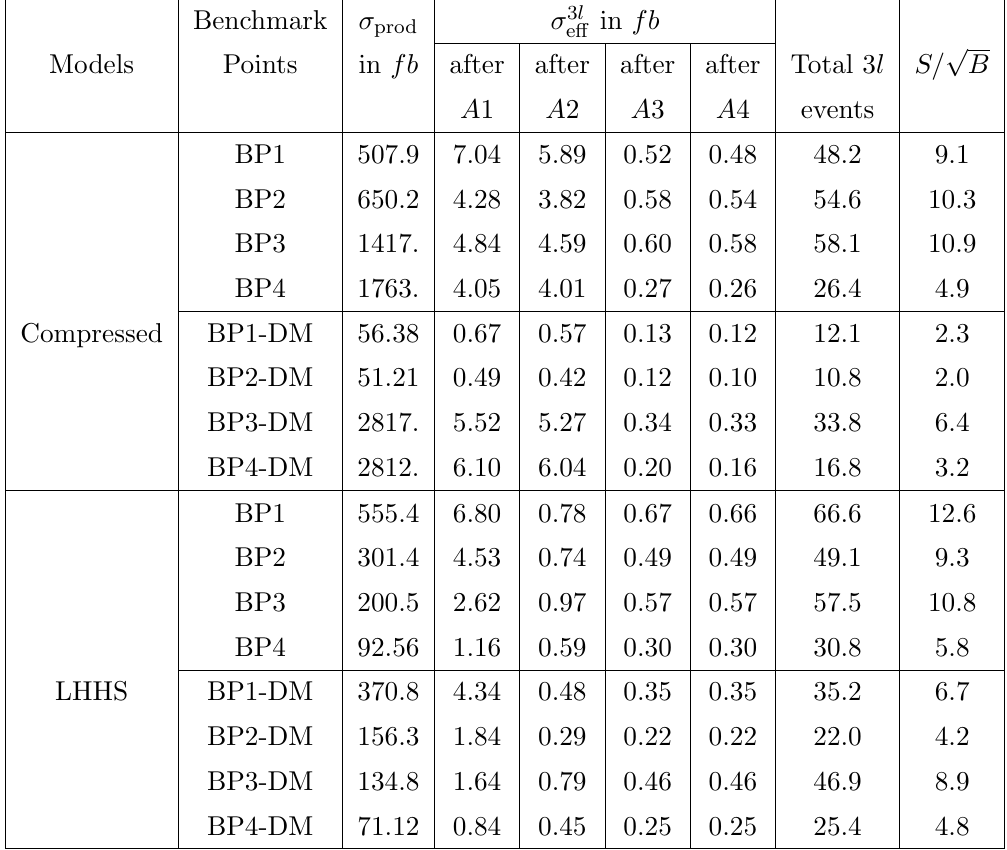
Table 9 . The production cross-sections of all EWeakino pairs and (cid:27) 3 l and table 6. Also the total number of 3 l events along with S= luminosity of 100 fb (cid:0) 1 .